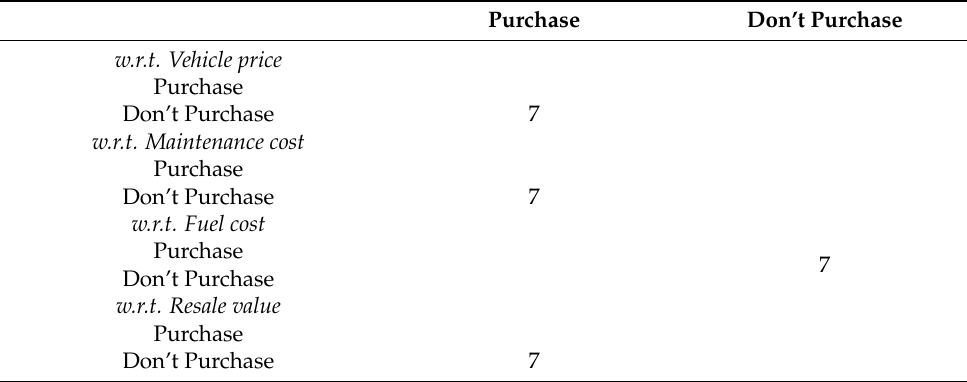
Table 13. Pairwise comparison matrix of Purchase and Don’t Purchase decision with respect to sub-criteria of COST OF